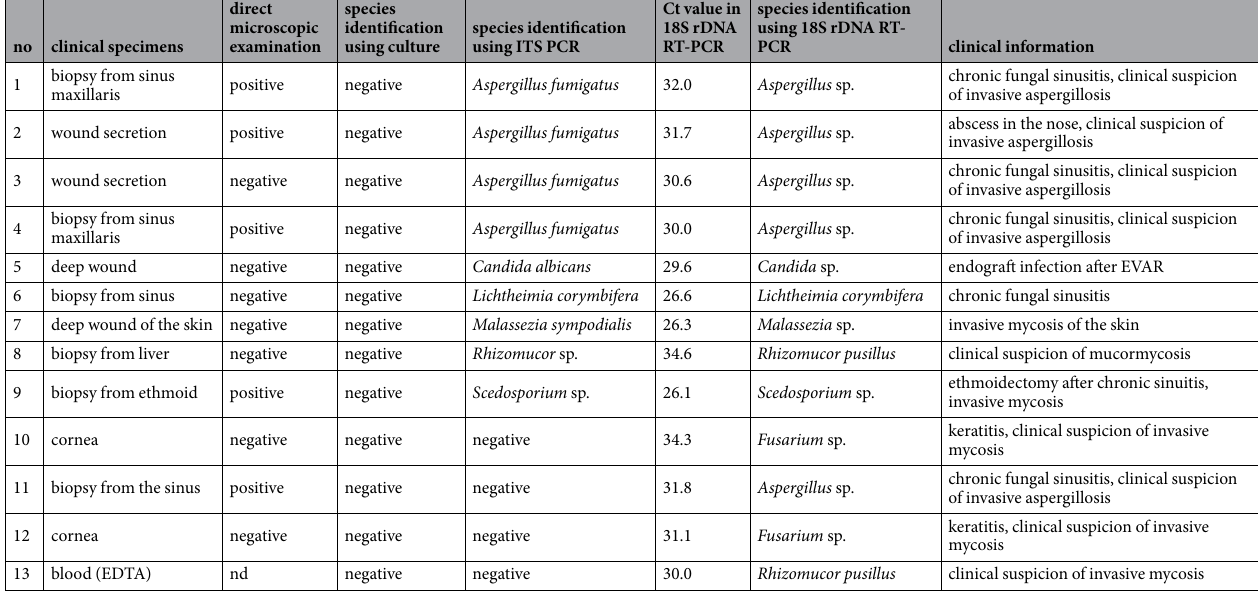
Table 4. Clinical specimens (N = 13) that showed discrepant results in fungal identification by culture and 18S rDNA